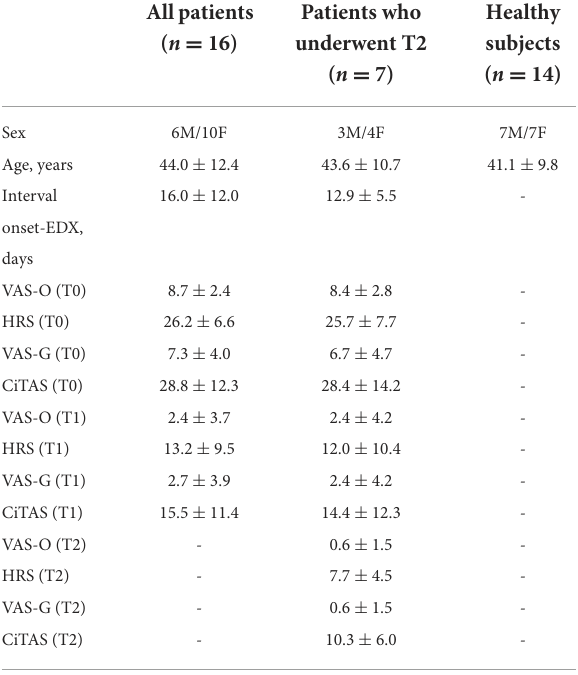
TABLE 1 Demographic and clinical characteristics of subjects